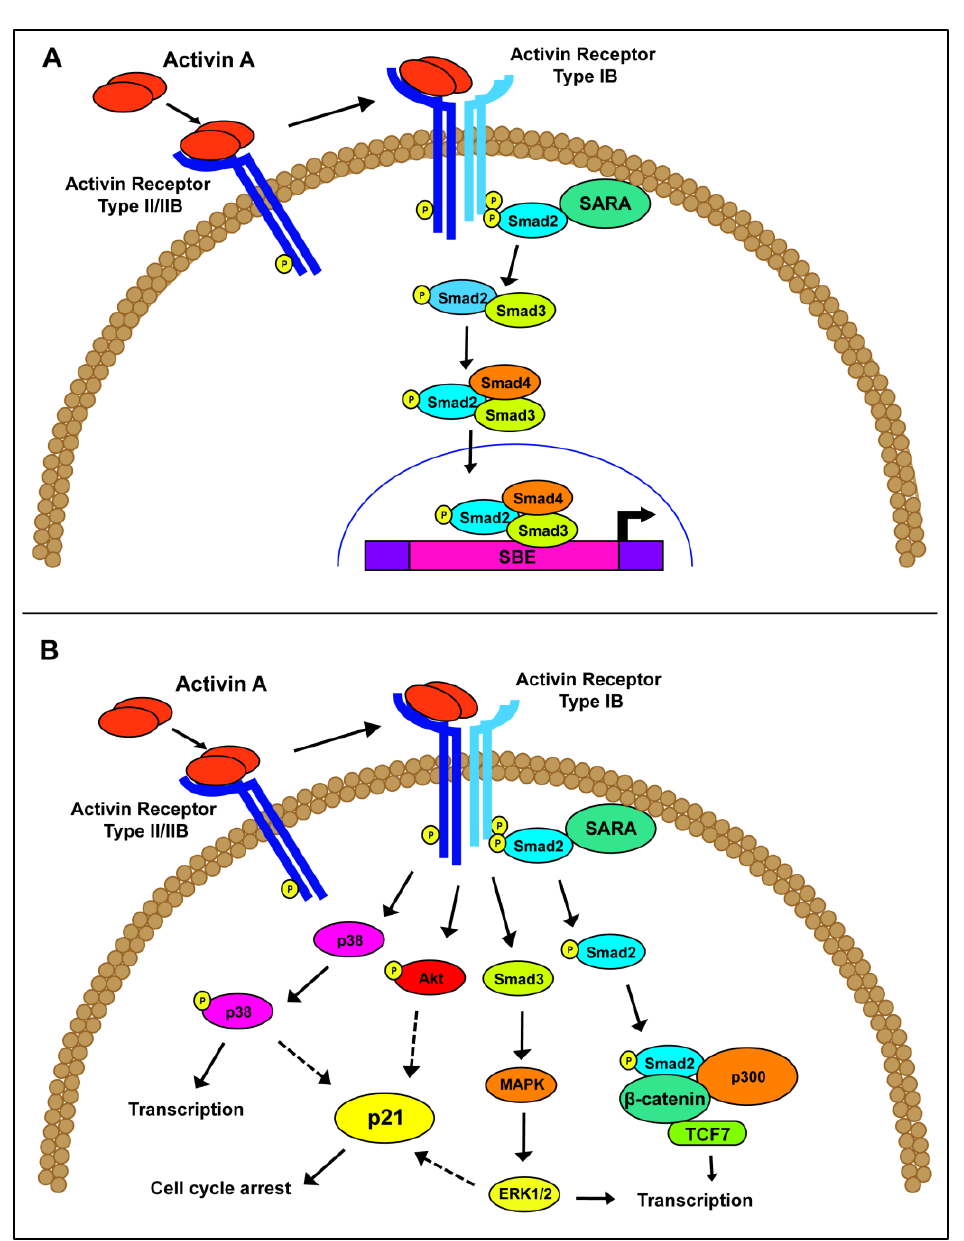
Figure 1. Schematic of activin A signaling. ( A ) Canonical activin A signaling occurs through the phosphorylation and activation of the Smad proteins, leading to downstream gene transcription. ( B ) Non-canonical activin A signaling has been postulated through a variety of pathways, including P13K/Akt, MAPK/ERK and